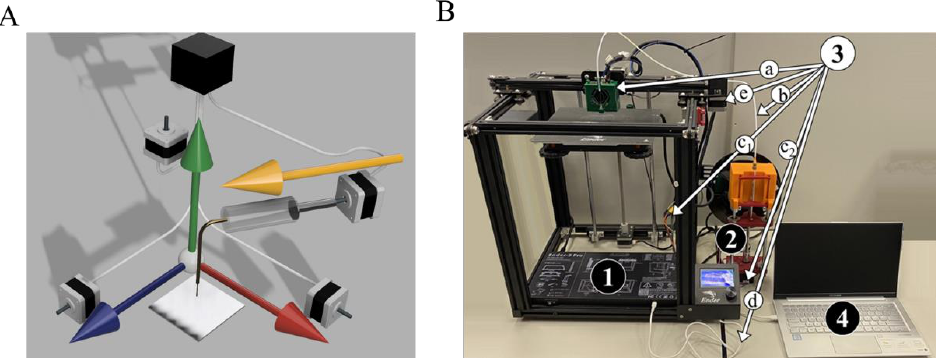
Figure 1. Principal scheme of the modified 3D printer for gel extrusion and its practical realization. ( A ). The scheme represents the general idea of any 3D printer, where the blue, red and green colored arrows represent the relative movement of the substrate-needle, and the fourth yellow arrow is for the filament axis. ( B ). A practical setup for extrusion printing of hydrogels and polymer solutions. The setup for extrusion printing of hydrogels and polymer solutions is as follows: (1) a commercial 3D-printer; (2) a plunger with a stepper motor to push the piston; (3) connection accessories: (a) header as a nozzle holder, (b) pipeline connection syringe to header, (c) re-connection wire to plunger stepper motor, (d) laptop plug, (e) stock stepper motor; and (4) a personal laptop.